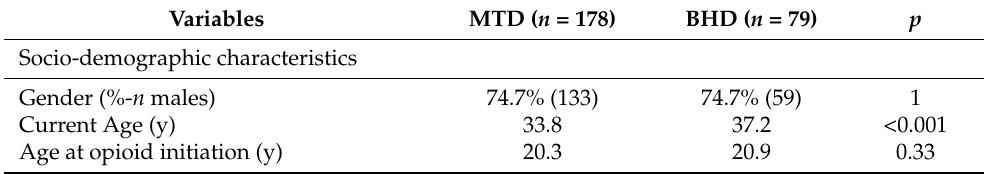
Table 1. Univariate comparative analysis of variables at Opioid Maintenance Treatment